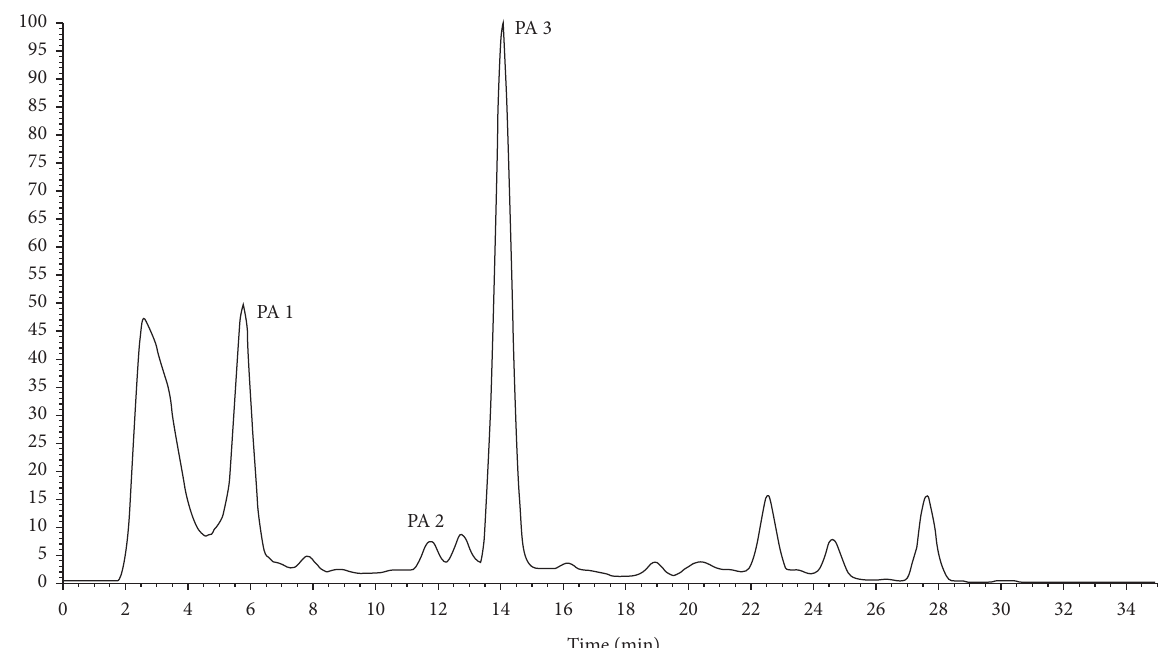
Figure 3: Chromatogram of total MS/MS fragment ion of 366 of QTproduced by Baiyunshan Company. Except PA1 (RT 5.79min), PA2 (RT 11.81min), and PA3 (RT 14.10min), other peaks in the chromatogram are non-PAs